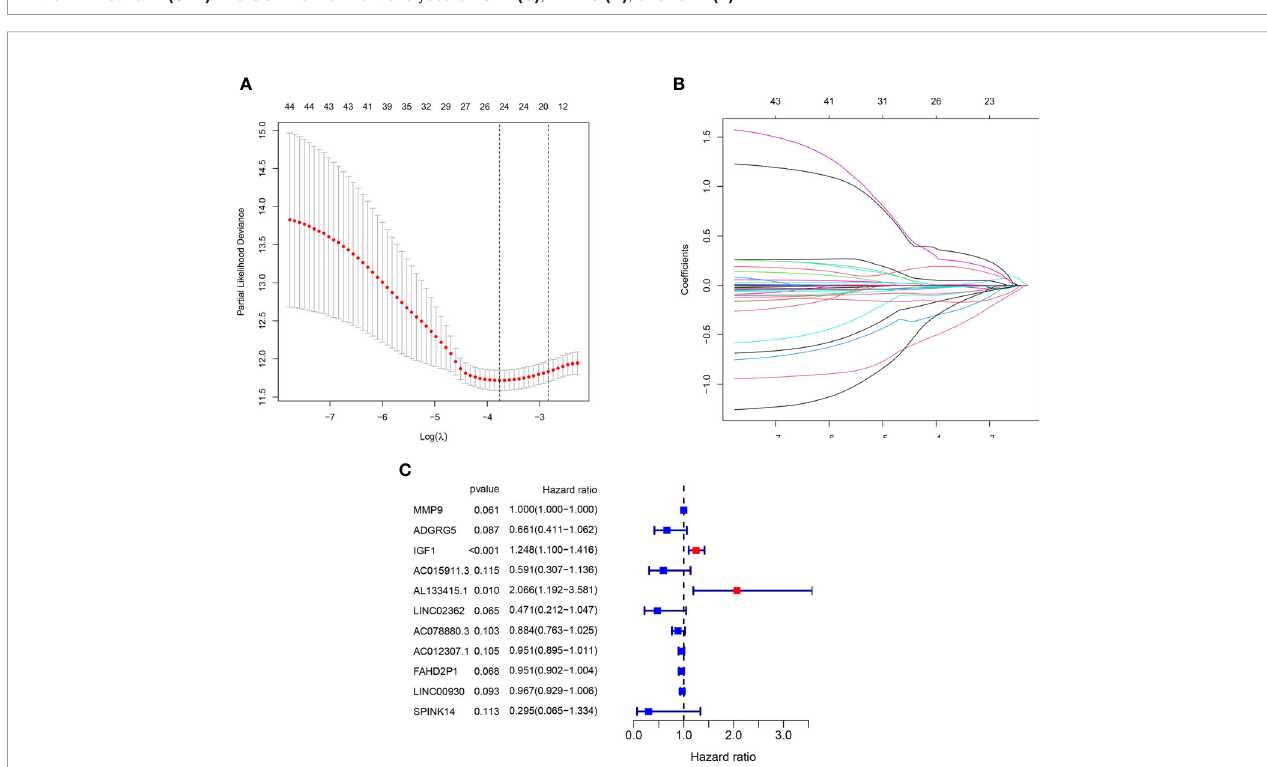
FIGURE 7 | Generation of the prognostic risk signature. (A, B) The LASSO regression analysis of the 45 PRDEGs. (C) The Forest plot showing eight hub genes selected by the multivariate regression